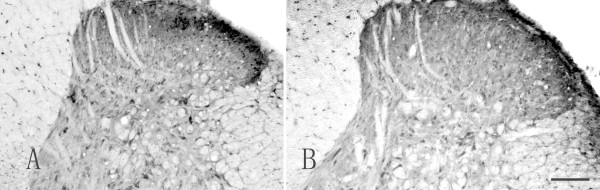
Incision-induced BDNF upregulation through nerve transmission. Representative photomicrographs of BDNF-IR in the ipsilateral lumbar spinal cord pretreated by saline (Figure 5A) or lidocaine (Figure 5B) sciatic nerve block followed by hind-paw incision. Bar = 150 μm.